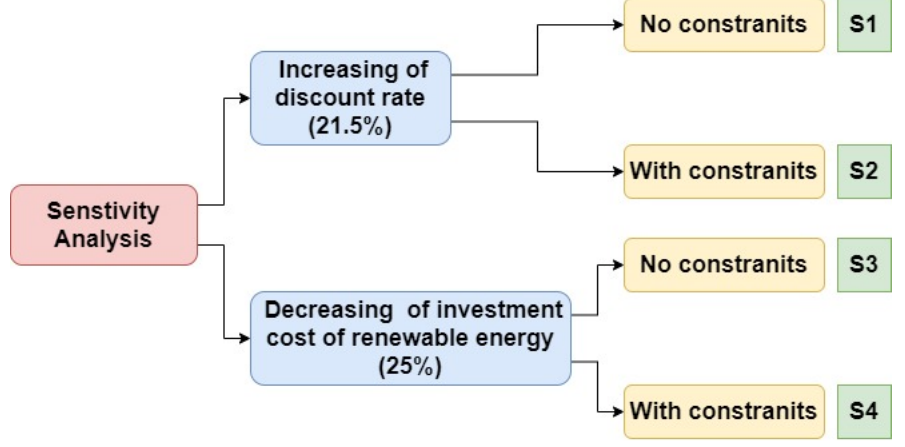
Figure 5. Scenarios used in sensitivity